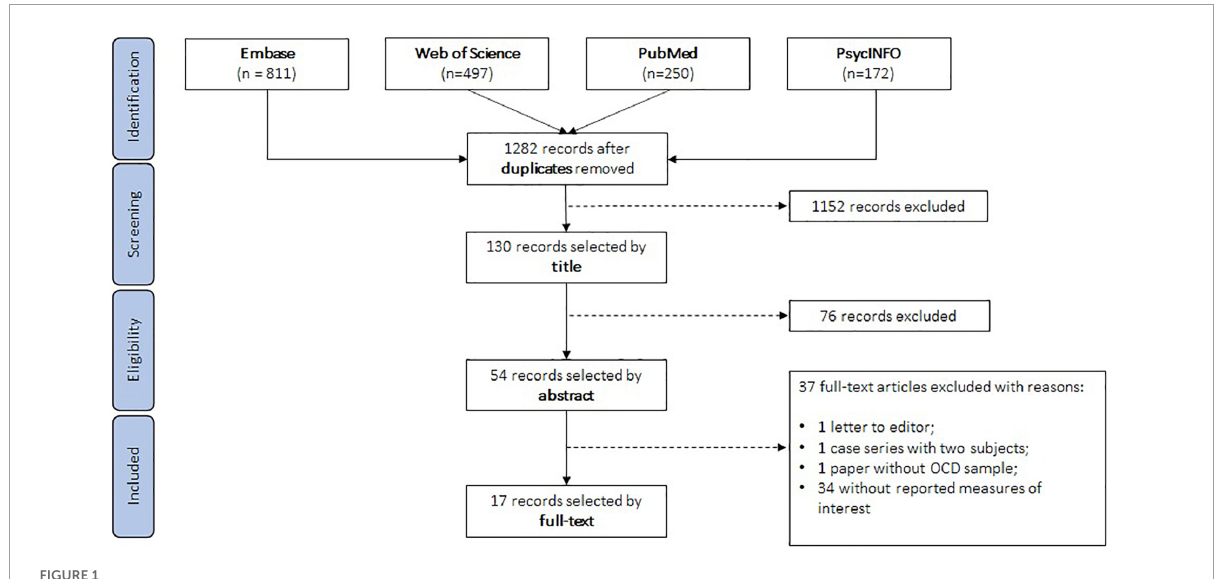
FIGURE1 Study selection